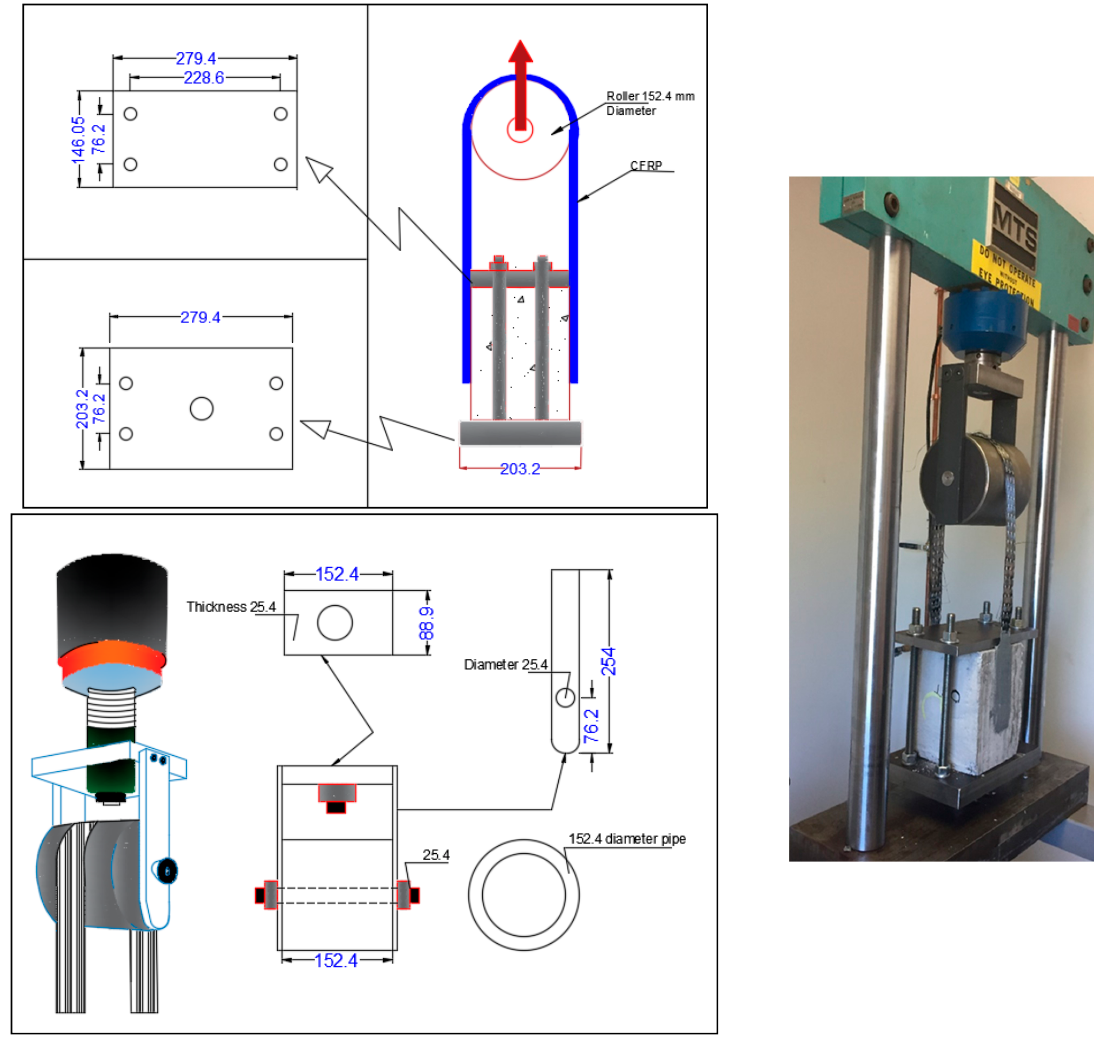
Figure 4. The pull-off shearing test set-up. (Dimensions are in mm).